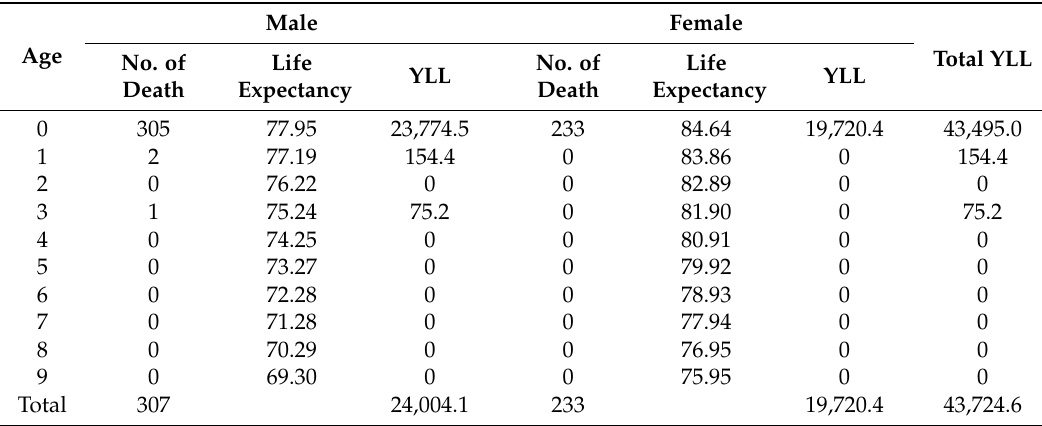
Table 4. YLL for preterm birth complications.